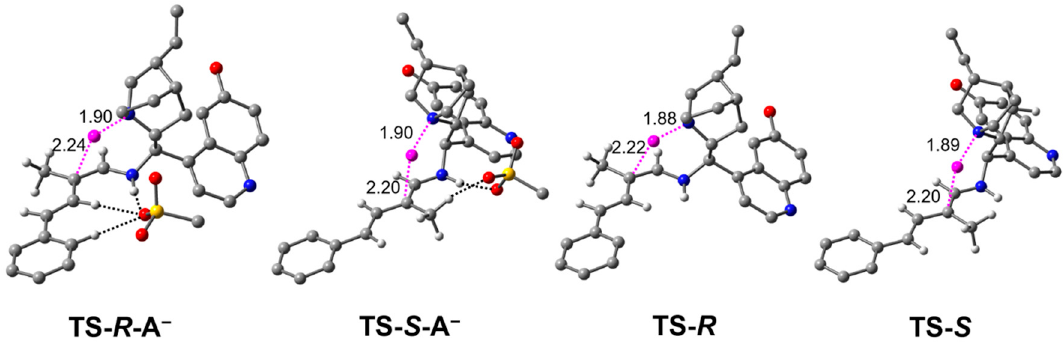
Figure 2. Calculated transition state (TS) geometries Breaking and forming bonds (purple, in Å) and important hydrogen bonds (black) are shown with dotted lines. Adapted with permission from [9].